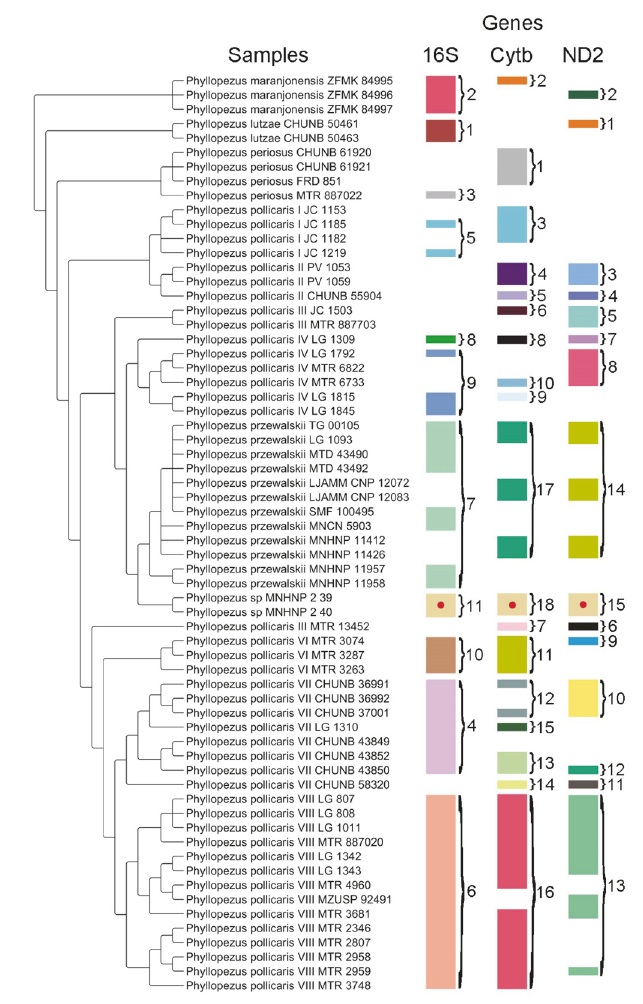
Figure 4: Results of ABGD analysis for each gene. Colors represent groups identified by ABGD for each gene, with group numbers presented at the right. As seen, not all samples were available for all genes. Group colors do not represent the same grouping among genes, except for samples from “Cordillera de Los Altos” which are identified with a cream colored box with a red central dot. Base phylogeny (at the left) is the same as for Figure